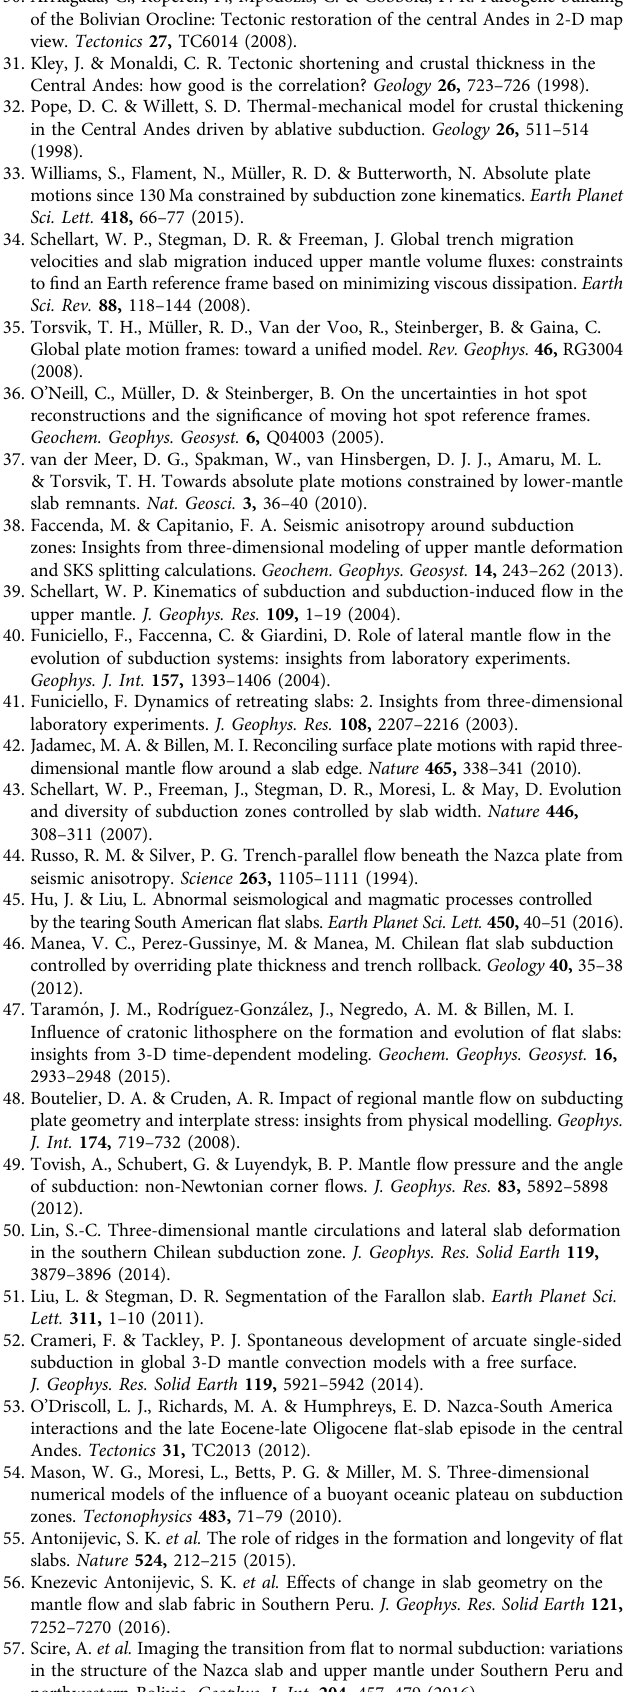
Data availability . The Gplates rotation and shape files, as well as a table of compiled shortening estimates and their literature sources that come with the Andes reconstruction are provided as Supplementary Files to this